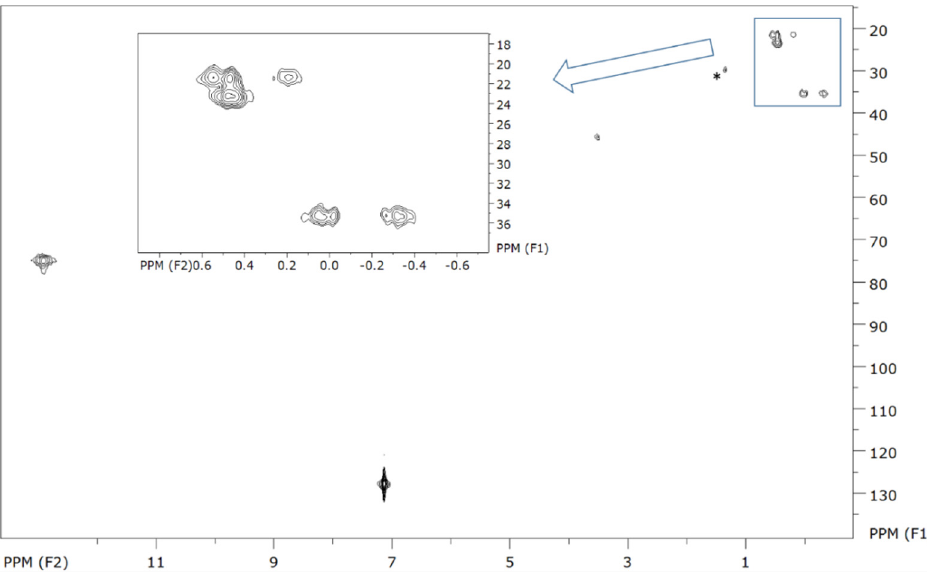
Table 2. Assignment of the 1 H and 13 C NMR resonance signals (ppm) of (Cp) 3 Pu(C ≡ NCy).